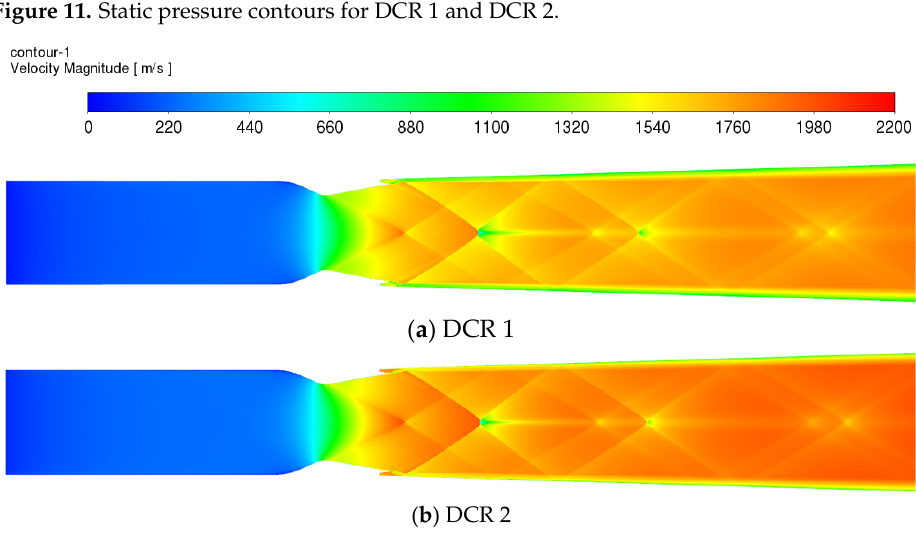
( b ) Figure 13. Species mass fraction for ( a ) DCR 1 and ( b ) DCR 2. 0.0